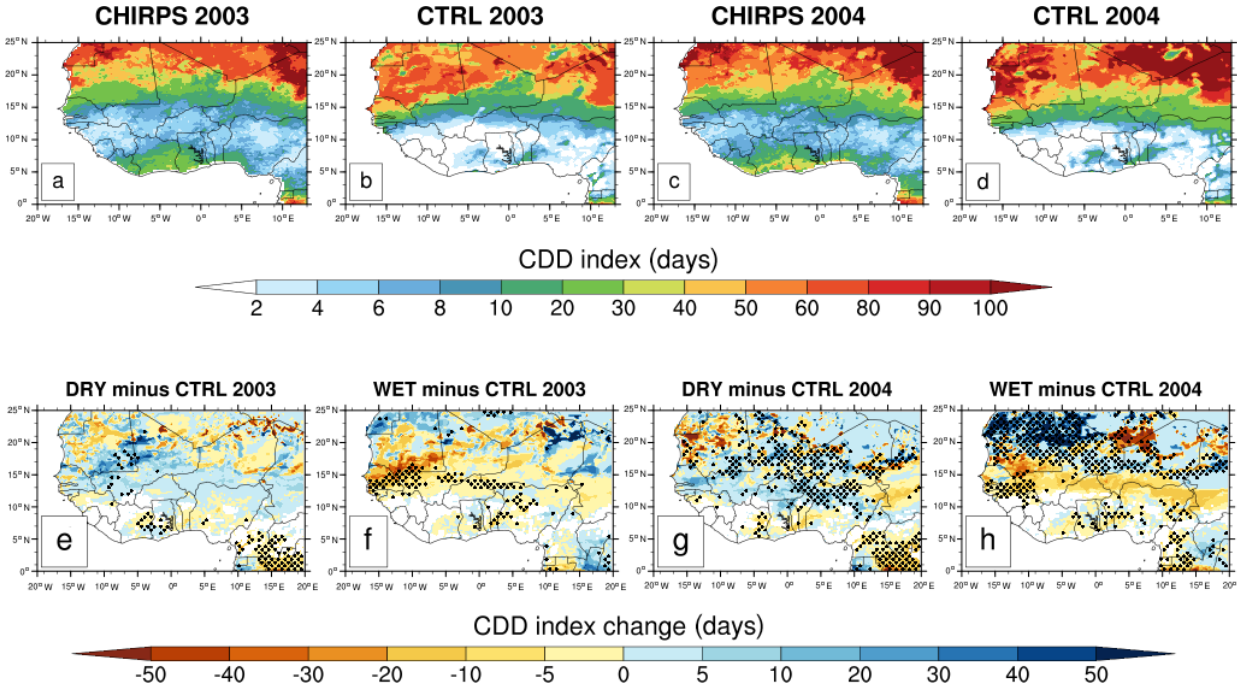
Figure 6. Same as Fig. 2 but for the CDD index (in days).